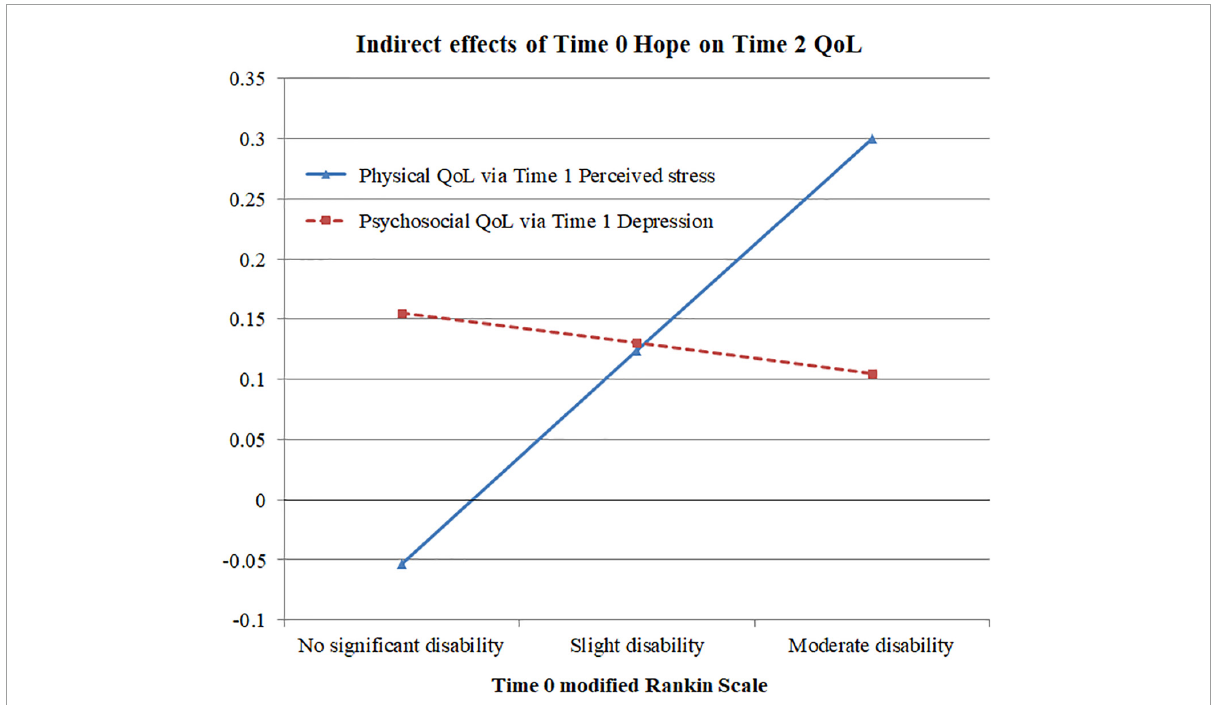
FIGURE2 Indirect effects of Time 0 hope on Time 2 physical and psychosocial quality of life among participants with various degrees of functional